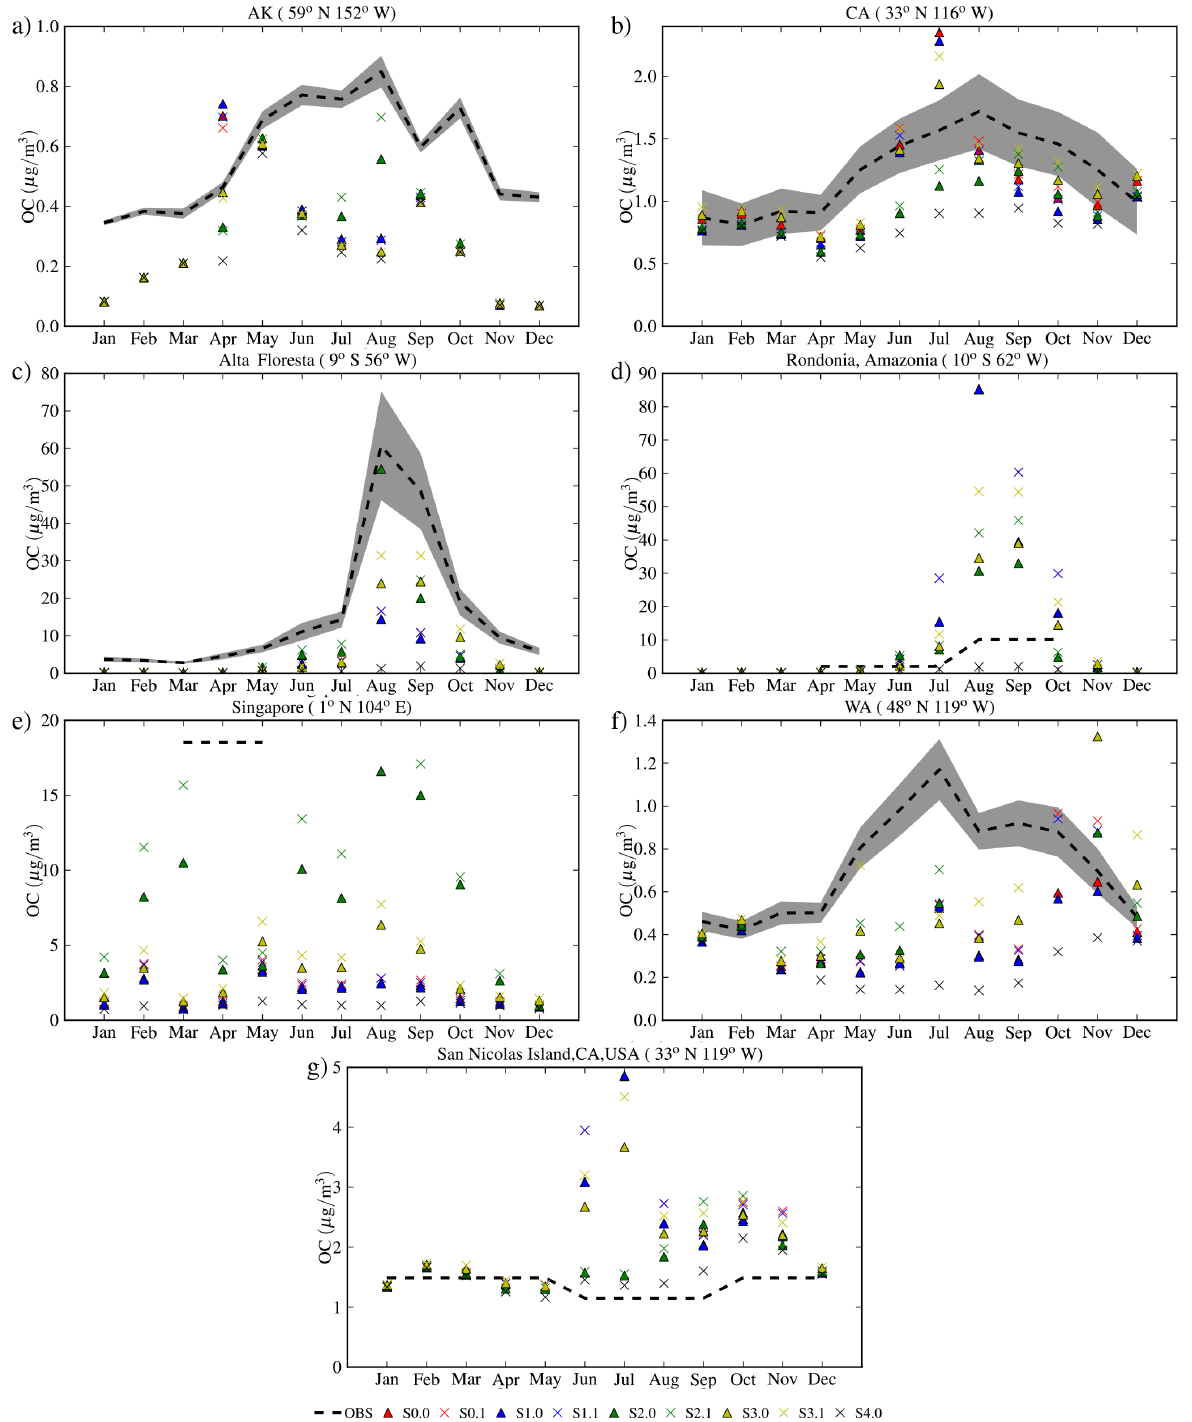
Figure 2. Comparison of monthly mean model results with observations of organic carbon (OC) at southern Alaska, USA (a) ; California, USA (b) ; Alta Floresta, Brazil (c) ; Rondonia, Amazonia, Brazil (d) ; Singapore (e) ; Washington State, USA (f) ; and San Nicolas Island, Cali- fornia, USA (g) . The dashed line with the gray shaded area shows the monthly mean value of observations with the standard deviation based on their interannual variability, while the colored symbols show the calculated values for the specific station. Triangles are for simulations assuming a vertical distribution of wildfire emissions, while the × symbols show the simulations assuming that all open biomass burning emissions occur near the surface. Details on the simulations are given in Table